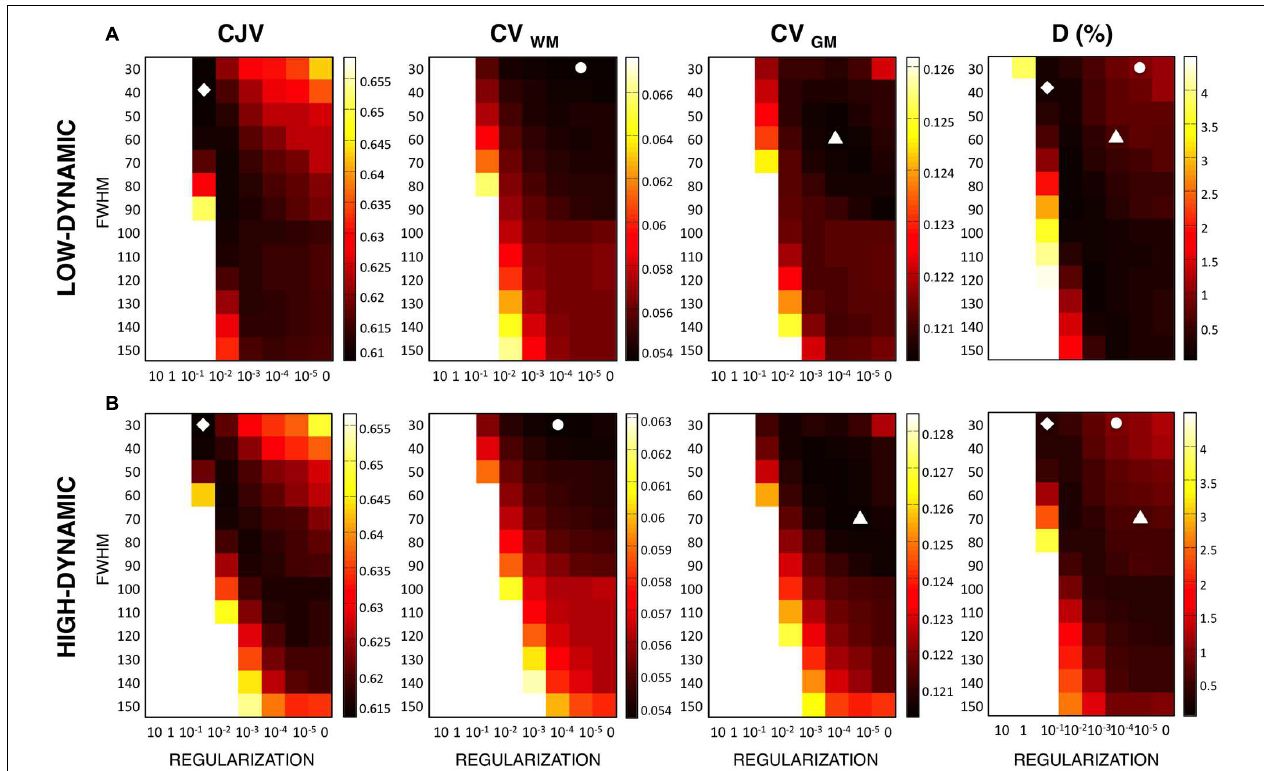
FIGURE 3 | Metric dependence on the INU correction results produced by different input parameters. In order to assess the performance of intensity inhomogeneity correction for each indirect metric, we analyzed several parameter configurations. In SPM, the regularization and the bias field smoothing (FWHM) parameters were varied accordingly. We computed the voxel-wise distance D between the simulated and the estimated INU field for each configuration, which was used as a reference. CJV (indicated with a diamond marker), CV WM (indicated with the circle marker), and CV GM (indicated with the triangle marker) are shown for the low-dynamic (A) and high-dynamic (B) profiles. The results shown in figure refer to the simulated MR dataset with 40% INU and 1% noise